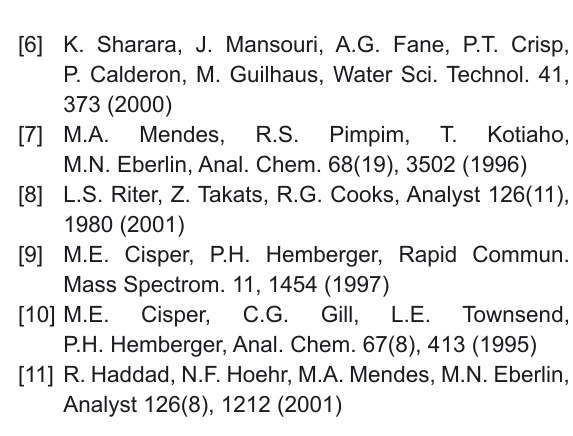
Table 1. Detection limits of selected non-polar hydrocarbons using CH Name of